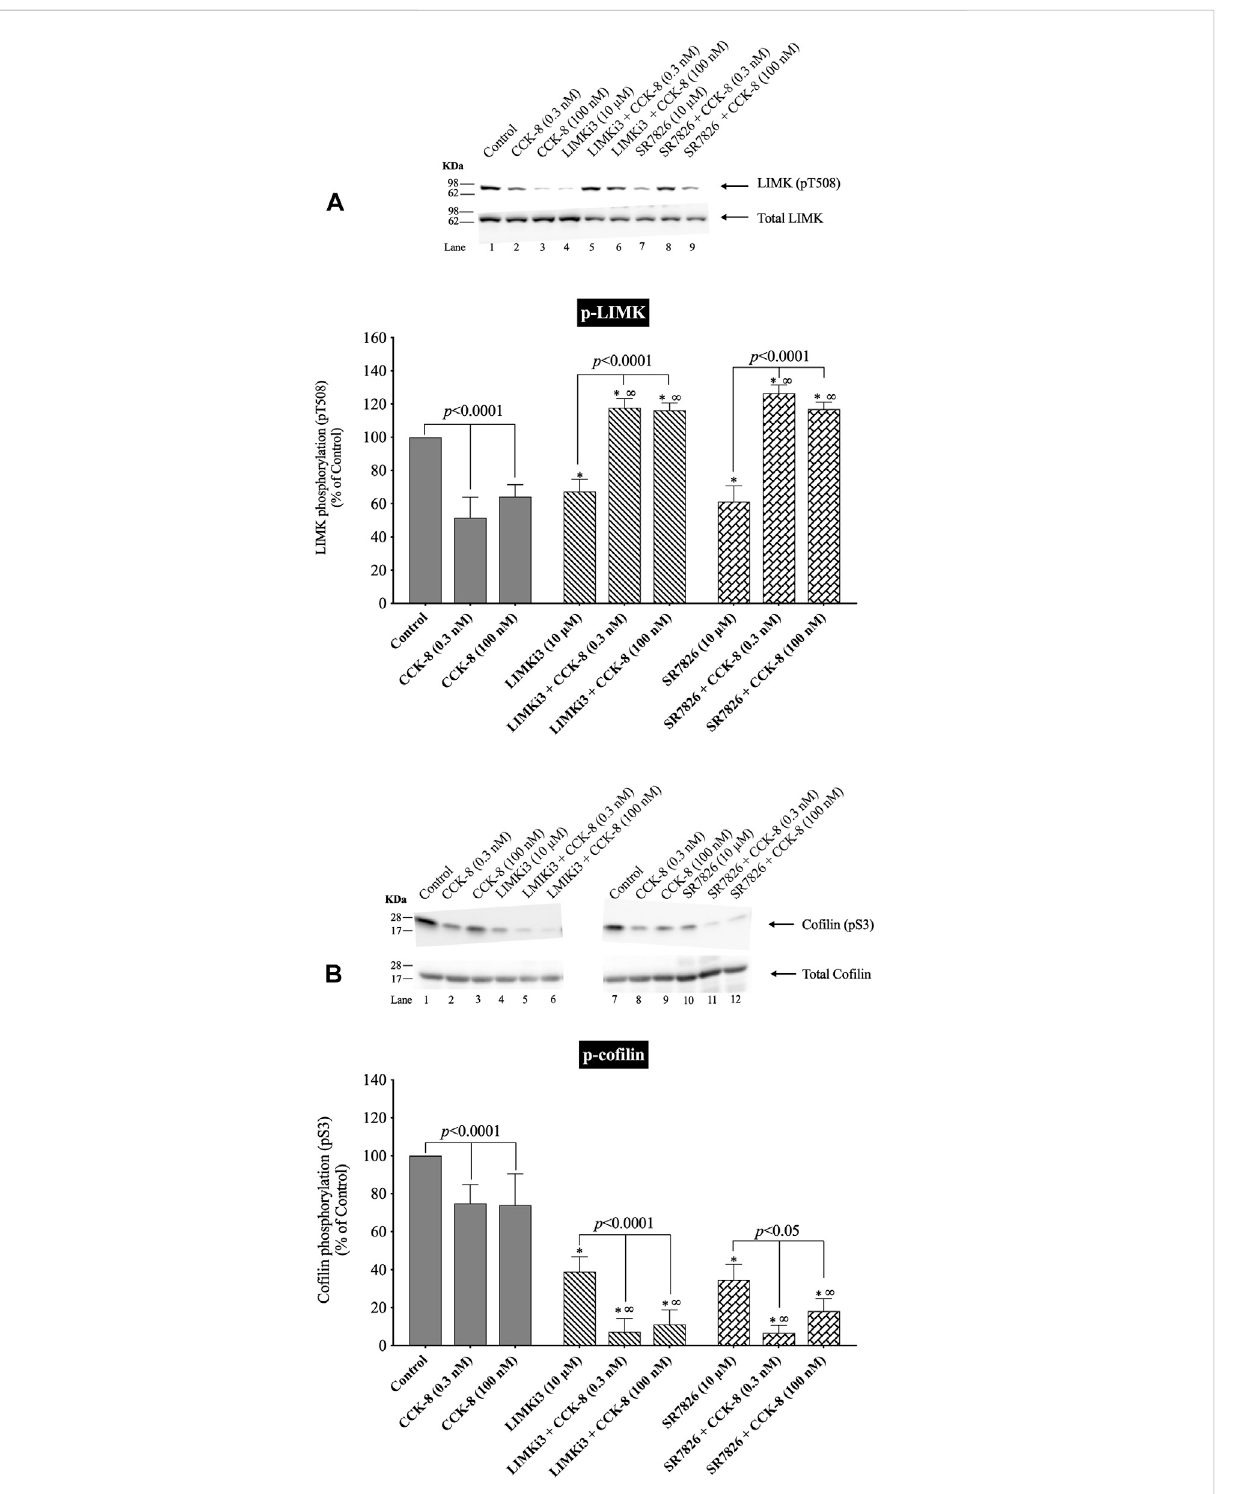
FIGURE 4 Effect of two LIMK inhibitors, LIMKi3 and SR7826, on the ability of CCK-8 (0.3 and 100 nM) to alter activation of LIMK (A) and co fi lin (B) . Isolated pancreatic acini were incubated in the absence or presence of LIMKi3 (10 µM) or SR7826 (10 µM) for 3 h and then incubated with no addition (control), CCK-8 (0.3 or 100 nM) for 3 min, and then lysed. Western blots were analyzed using anti-pT508 LIMK and anti-pS3 co fi lin. Bands were visualized using chemiluminescence and quanti fi ed by densitometry. Top : Results of a representative blot of four independent experiments are shown. Bottom : Means ± S.E. of at least 4 independent experiments. Results are expressed as % of basal stimulation of the control group. *, p < 0.05 compared to the control group; ∞ , p < 0.05 compared to stimulants without